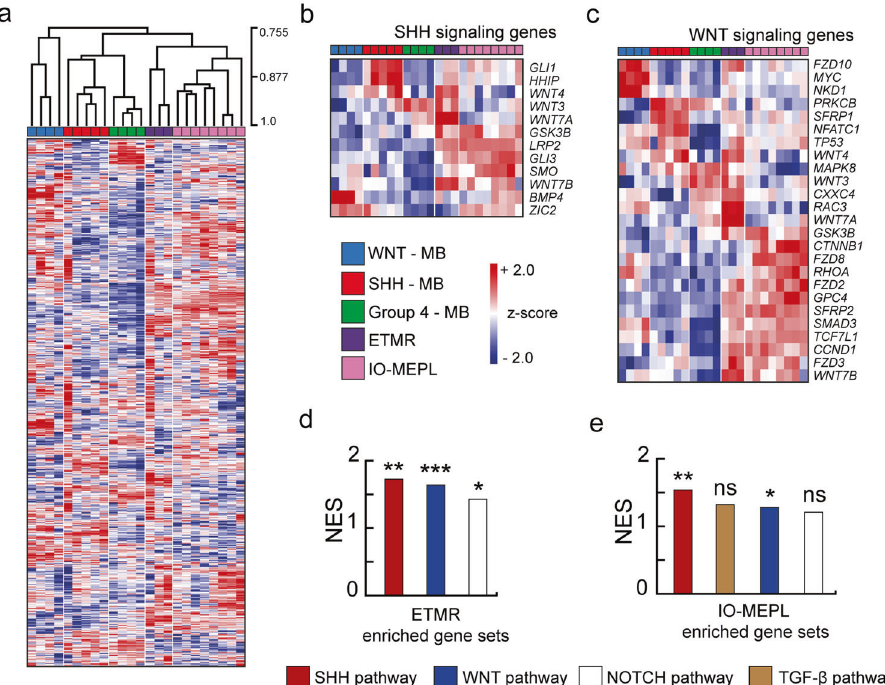
Fig. 1 Gene expression analysis of IO-MEPLs and intracranial embryonal tumors. a Unsupervised hierarchical clustering based on expression of 770 genes of the PanCancer pathways panel (Nanostring Technologies). ETMRs and IO-MEPLs formed individual groups within a distinct shared dendrogram branch that separates the entities from molecular medulloblastoma subgroups. Distance method used was Pearson correlation; dendrogram drawing method used was average linkage. b , c Expression pro fi les based on differentially expressed genes of the Sonic hedgehog (SHH, b ) and WNT ( c ) pathways displayed common upregulated target genes in IO-MEPLs and ETMRs (ANOVA test with adjusted Bonferroni correction). SHH and WNT gene sets were de fi ned by the PanCancer pathways panel. Note the robust upregulation of CTNNB1 and SMO in IO-MEPLs. d , e Gene set enrichment analysis (GSEA) reveals overrepresentation of both Wnt and Shh signaling pathway genes in ETMRs ( d ) as well as IO-MEPLs ( e ). Analysis was performed based on prede fi ned Nanostring gene sets with Group 4-MBs used as a reference. Gene sets with an FDR value <0.25 are shown. Asterisks indicate signi fi cance: p value < 0.05*, <0.01**,